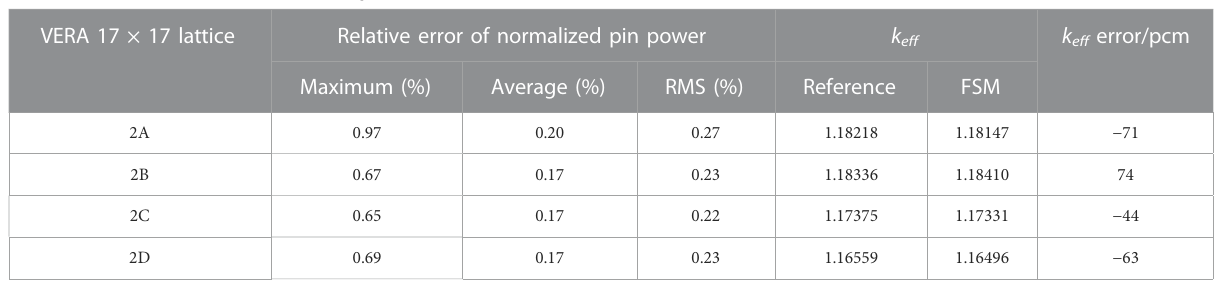
TABLE 9 Calculation results for VERA lattice problems. VERA 17 × 17 lattice